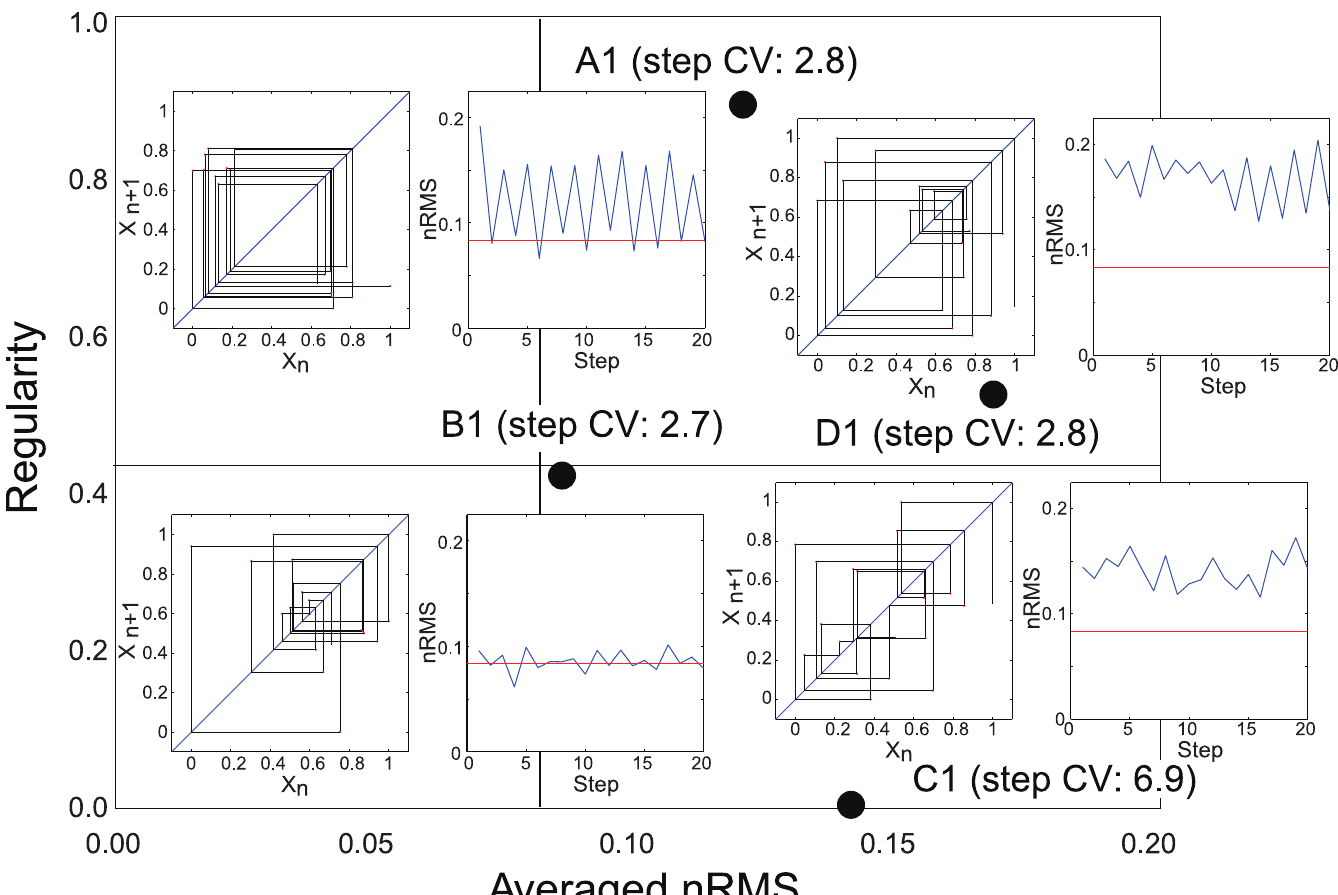
Fig 3. Examples of return map and time series for C7. Left side of each subfigure shows the return map. The x -axis is Xn times, and the y -axis is Xn + 1 times the amplitudeof nRMS, which was standardized from 0 to 1 in each participant. The right side of each subfigureshows the time series of nRMS. Red lines show the mean of the averaged nRMS in pooledparticipants. The value in each exampleshows step CV in each participant.